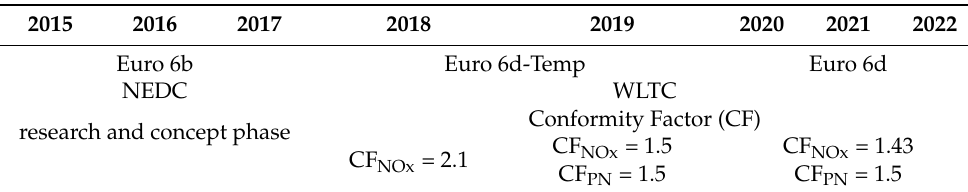
Table 1. Requirements for RDE testing in Europe [3–6].